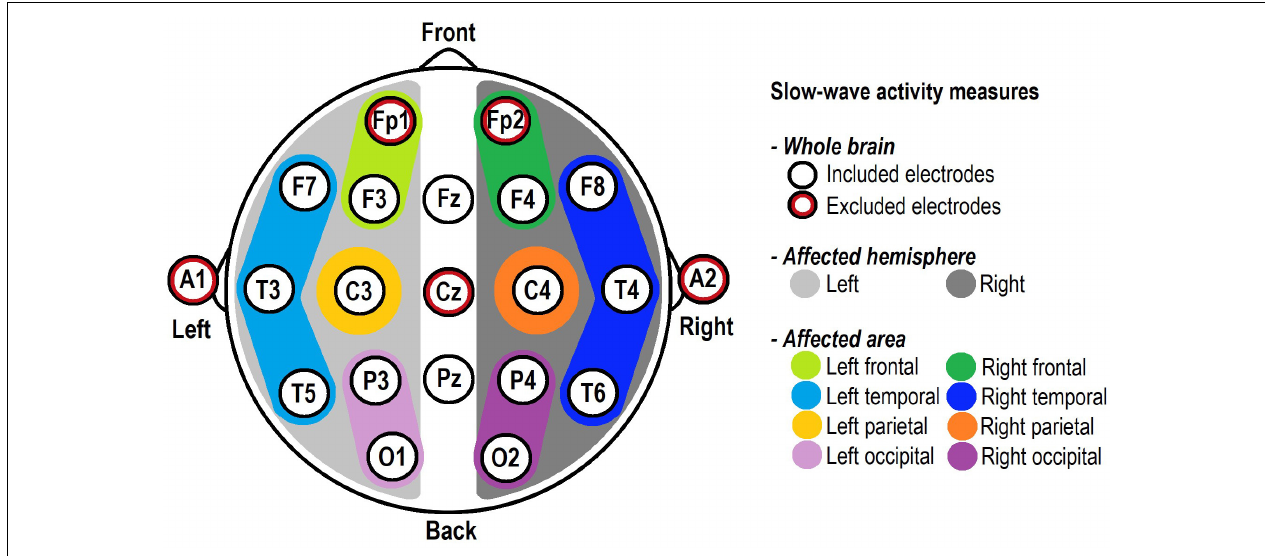
FIGURE 1 | Electrode positions according to the International 10–20 System and their involvement in the slow-wave activity measures. The five red-circled electrodes were excluded from all analyses. “Whole brain” included the 16 remaining electrodes, whereas “Affected hemisphere” and “Affected area” included the electrodes corresponding to each patient’s individual tumour